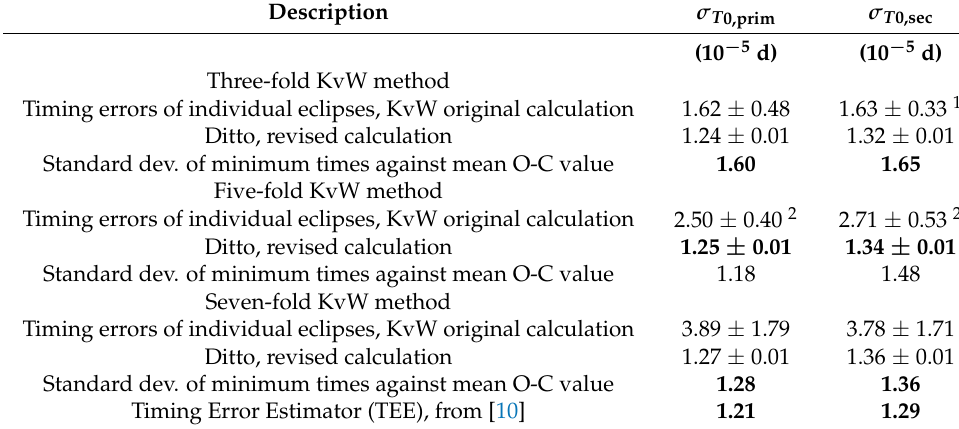
Table 2. Timing precision of CM Dra eclipses obtained by different methods discussed in the text, for primary and secondary eclipses. Values explicitly mentioned in the text are presented in